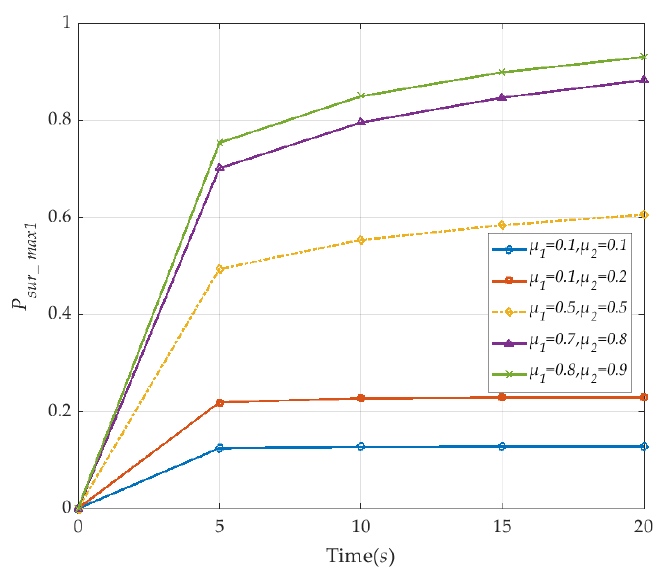
Figure 6. The maximum probability of V2I network survivability with respect to the time (corresponding to μ 1 and μ 2 ).